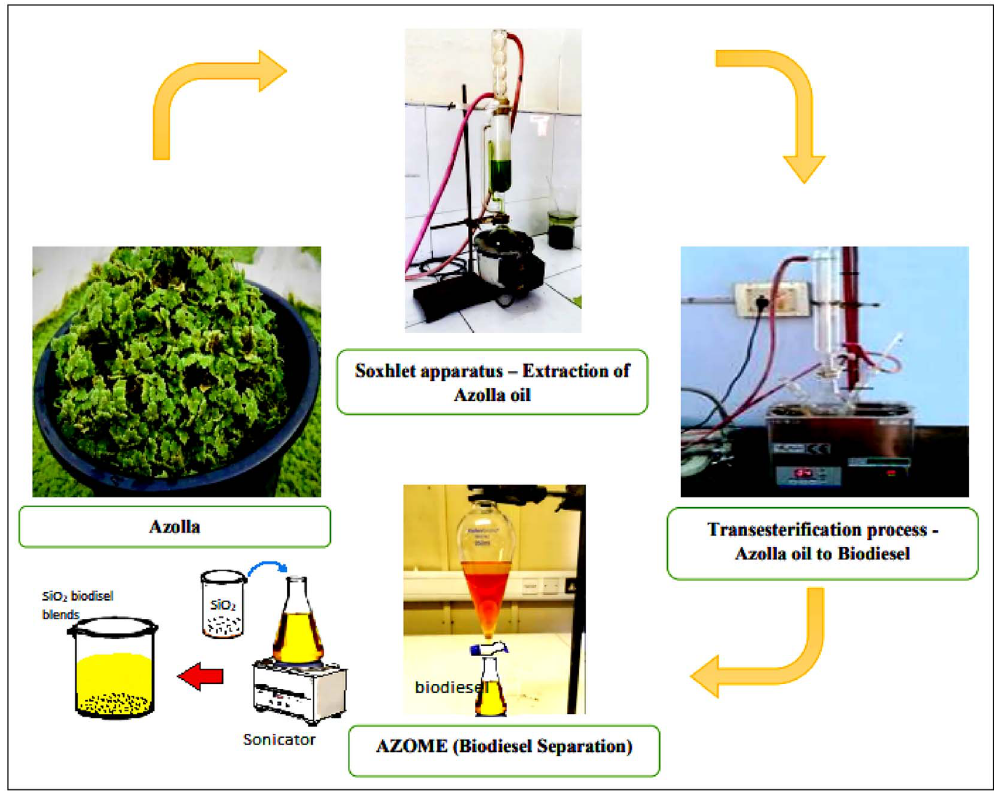
Figure 1. Biodiesel preparation from Azolla